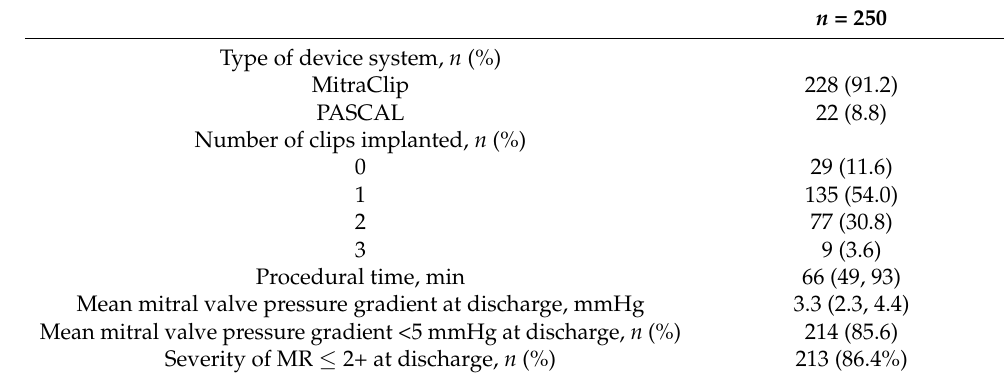
Table 2. Procedural characteristics of TEER.